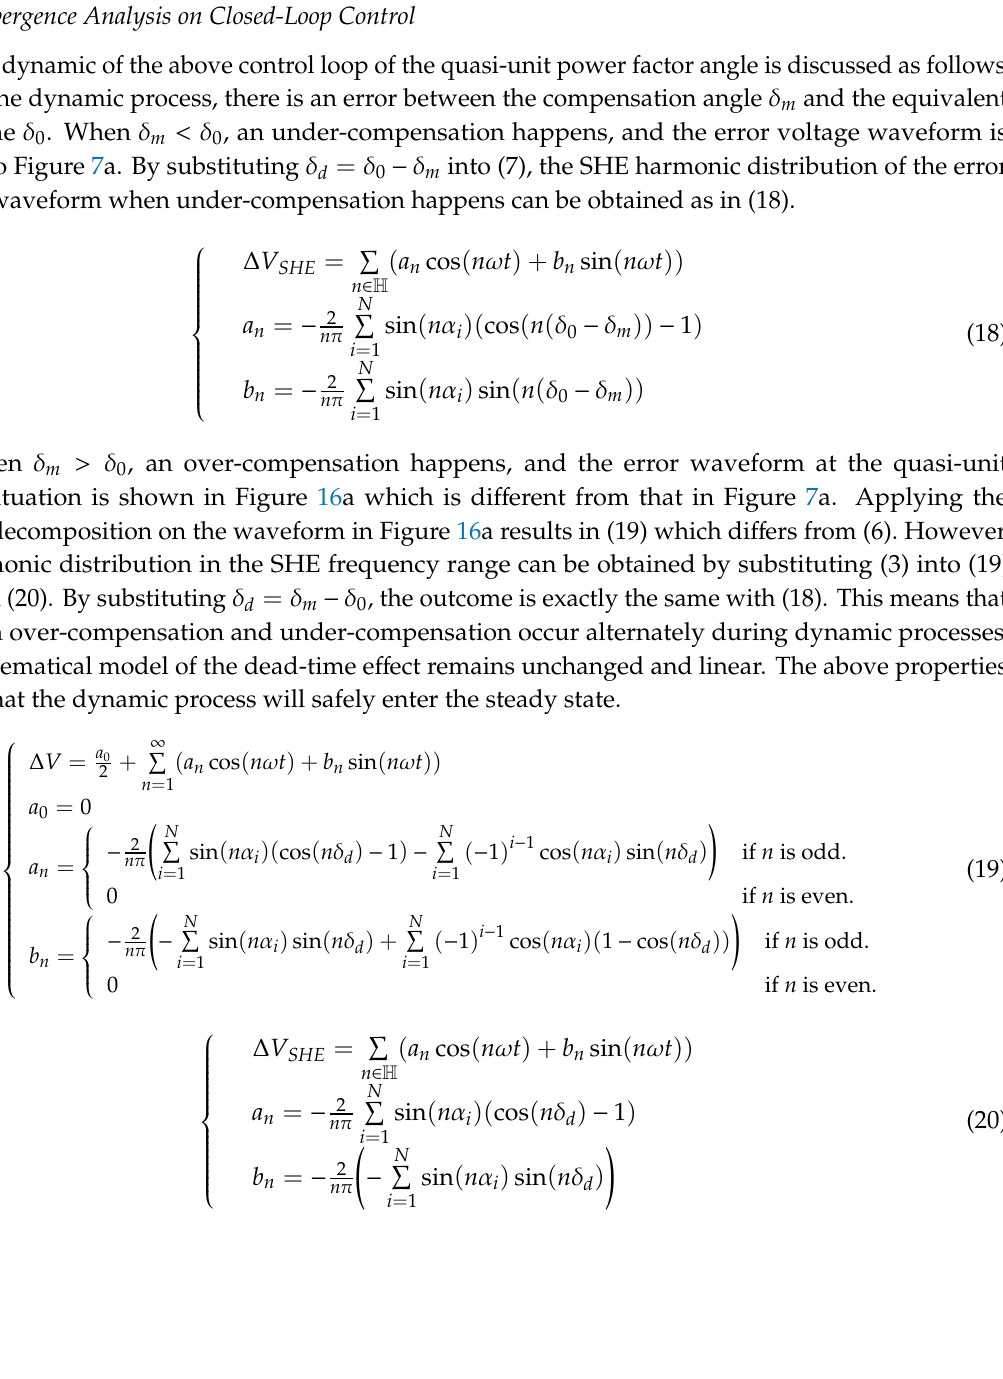
Figure 15. The complete adaptive dead-time compensation method.